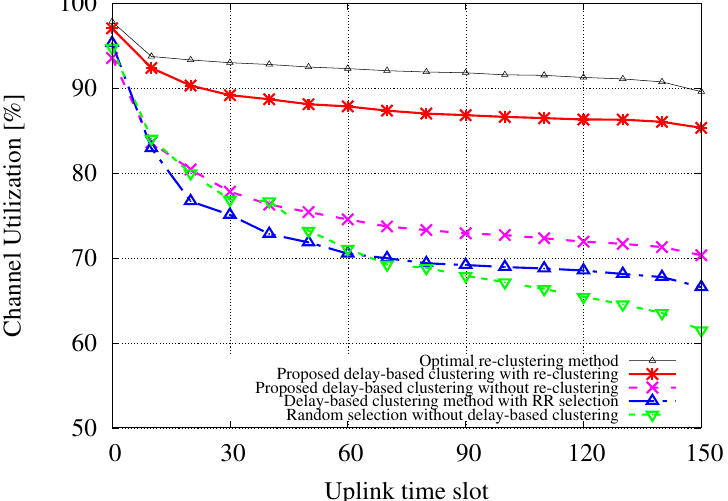
Figure 14. Channel use